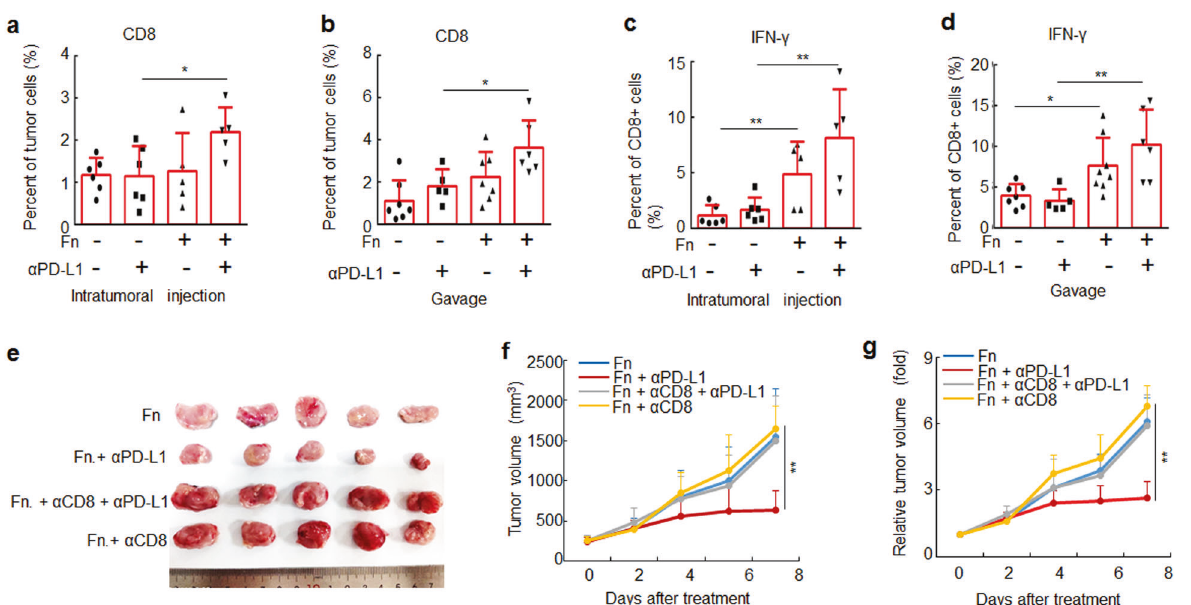
Fig. 3 F. nucleatum increases the accumulation of CD8 + IFN- γ + TILs during treatment with an anti-PD-L1 mAb. a , b CT26.WT cells were subcutaneously injected into BALB/c mice. Tumor-bearing mice were treated with PBS or F. nucleatum by intratumoral injection and intraperitoneally injected with an anti-PD-L1 mAb or an isotype control mAb. a , c Flow cytometry was used to detect CD8 + cells in tumor tissues from mice and the proportion of IFN- γ + cells in CD8 + cells. One-way ANOVA and Bonferroni ’ s multiple comparison test. b – d CT26. WT cells were subcutaneously injected into BALB/c mice. Tumor-bearing mice were treated with PBS or F. nucleatum by garvage and intraperitoneally injected with an anti-PD-L1 mAb or an isotype control mAb. c , d Flow cytometry was used to detect CD8 + cells in tumor tissues from mice and the proportion of IFN- γ + cells in CD8 + cells is shown. One-way ANOVA and Bonferroni ’ s multiple comparison test. e Tumor-bearing mice were intraperitoneally injected with an anti-CD8 mAb or an isotype control mAb, then mice were treated with PBS or F. nucleatum by intratumoral injection and intraperitoneally injected with an anti-PD-L1 mAb or an isotype control mAb. An image of tumors collected at the end of the experiment is shown. f , g Tumor volumes and relative tumor volumes at various time points are shown. One-way ANOVA and Bonferroni ’ s multiple comparison test. Bars, s.d. * P < 0.05; ** P < 0.01. Fn, F.